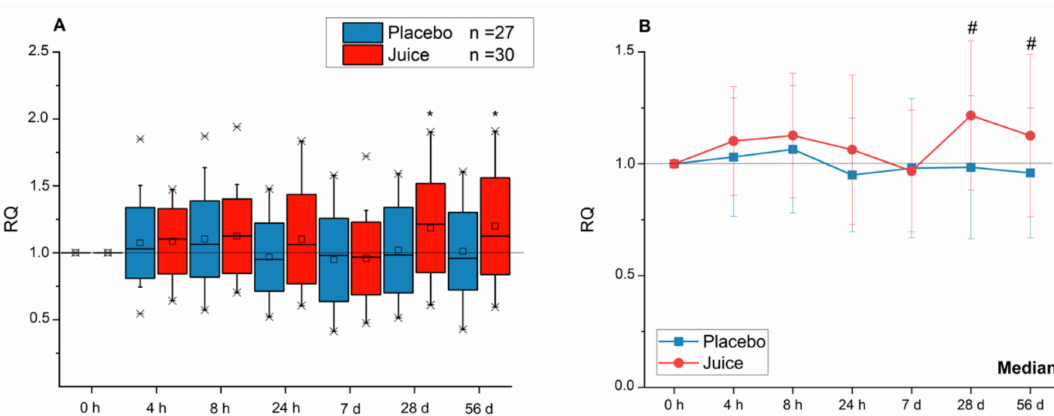
Figure 2. Modulation of HO-1 gene transcription after 4-, 8-, 24-h and 7-, 28-, 56-day intake of anthocyanin-rich multi-fruit juice (juice, n = 30) or placebo (placebo, n = 27). ( A ) The relative transcript levels were normalized to the means of ACTB and GAPDH and the negative control (transcript levels at time point 0 h; RQ). ( B ) Line graphs represent the median values of relative transcript levels (RQ) ± SD. Significance compared to the control is calculated by Kruskal–Wallis test with * = p < 0.05; significances relative to placebo group with # = p <0.05.